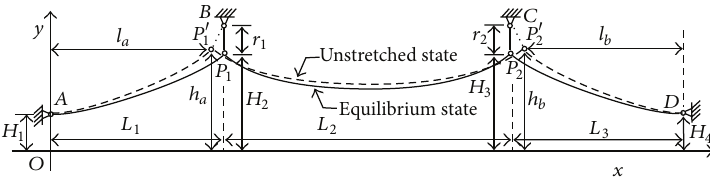
Figure 1: The configuration of three-span